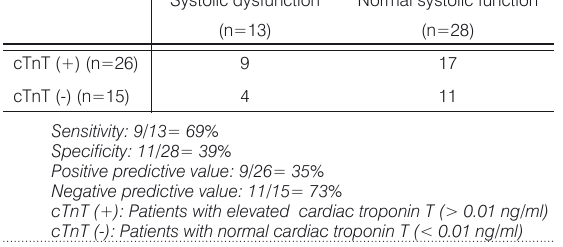
Table 1. Sensitivity and specificity of cTnT for the detection of systolic dysfunction at 1 year.